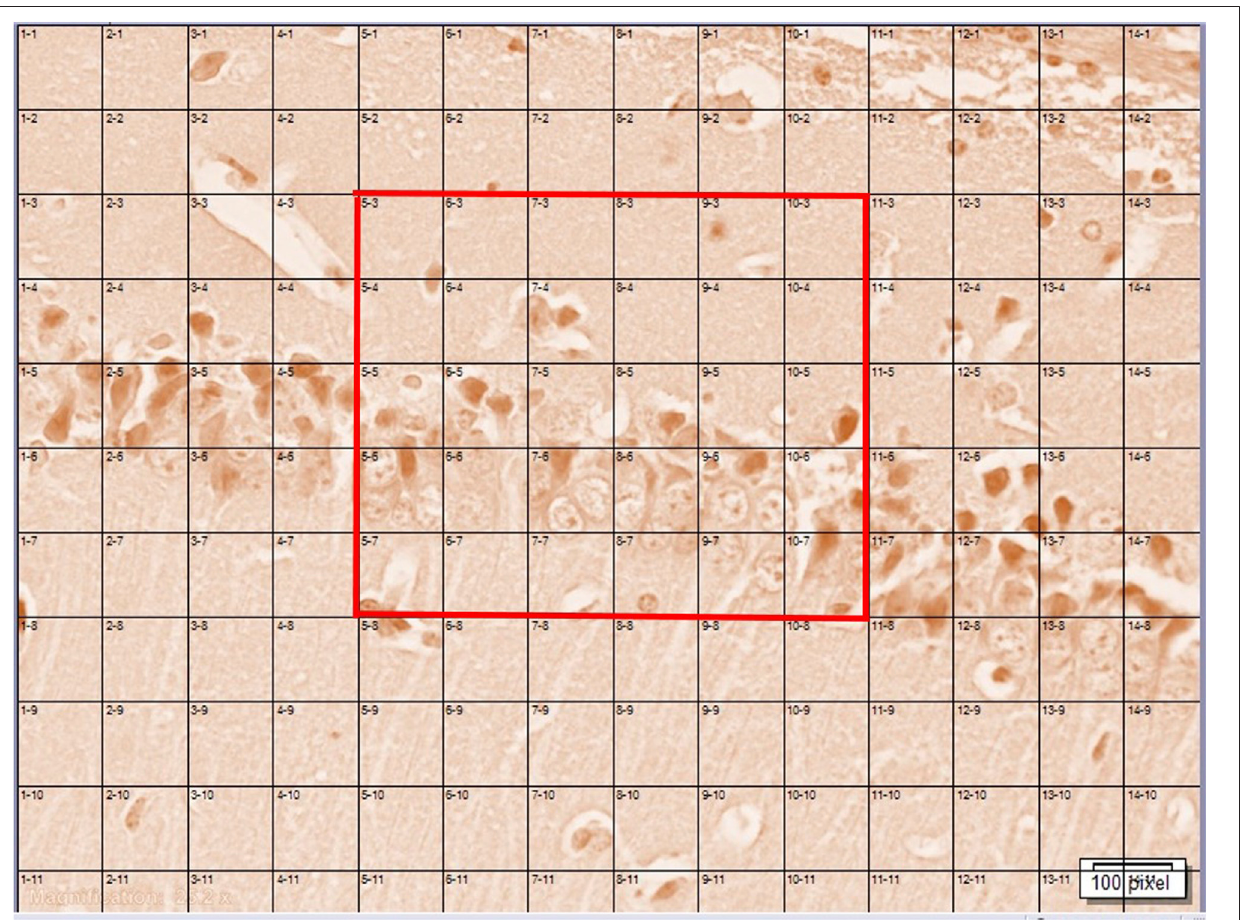
FIGURE1| Arectangleconsistingof30squares(6 × 5)(shownbyredcolor)whichwerecountedforthenumberofamyloidplaquesintheAC1,AC3,andDGareas of the hippocampus.